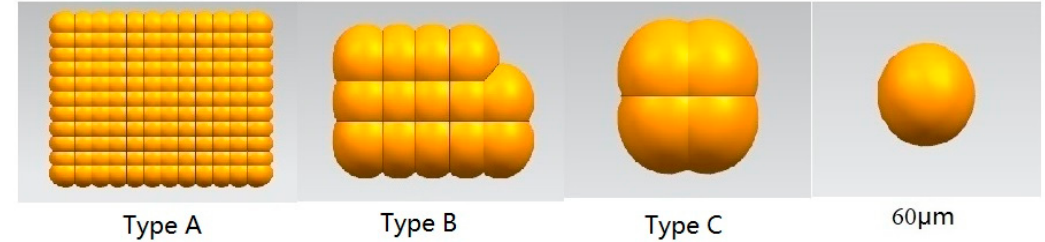
Figure 1. The axial length of Z axis and cross section of the cylinder of the hydrocyclone.